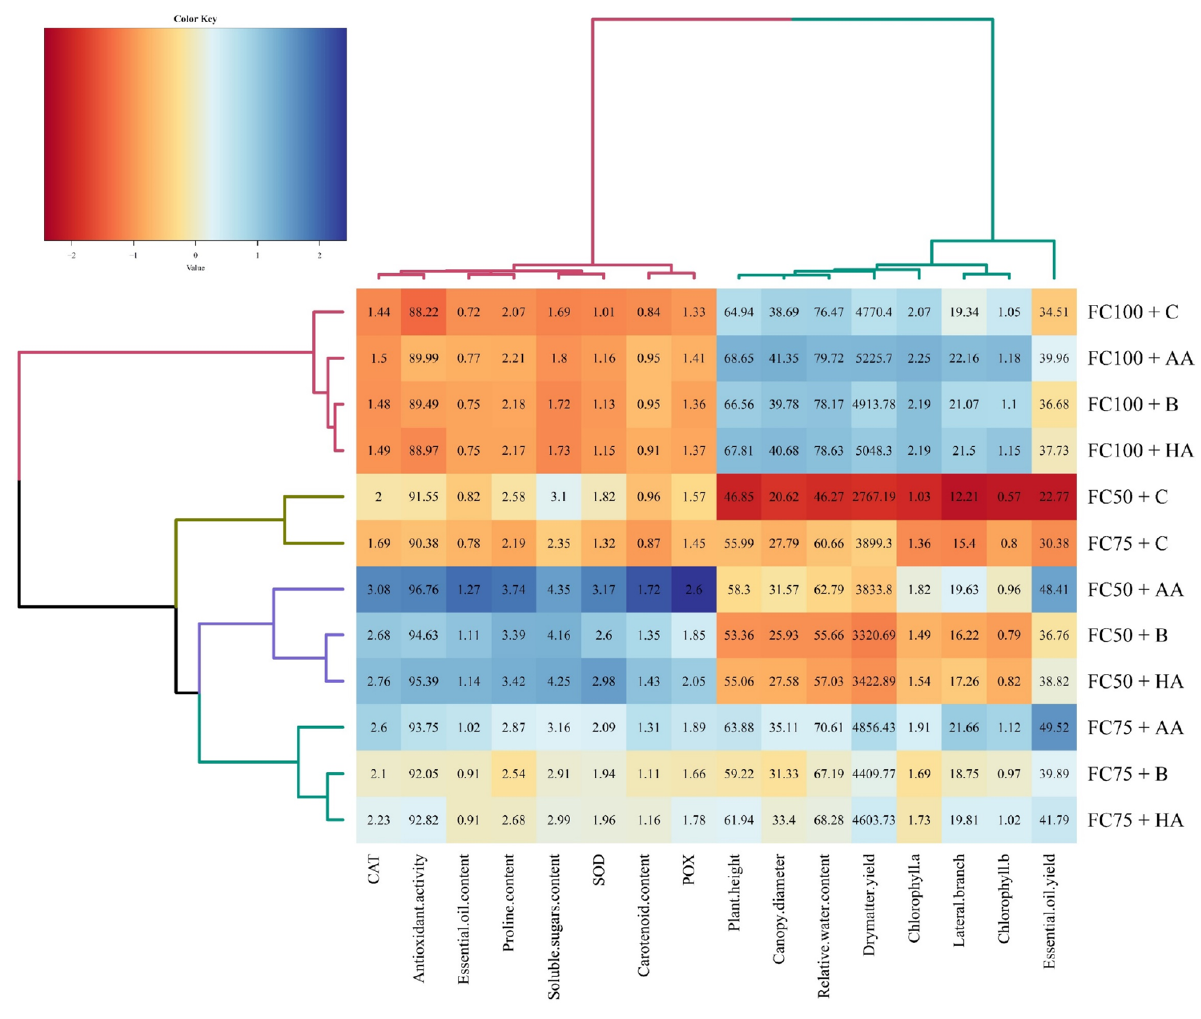
Figure 5. Heatmap clustering of irrigation regime (FC100, 100% field capacity; FC75, 75% field capacity; FC50, 50% field capacity) and fertilizer application ( C control, HA humic acid, B bacterial, AA amino acid) sources based on morpho-physiological characteristics in summer savory ( Satureja hortensis L.). The key color bar indicates standardized mean values (dark red indicates relatively low mean values; dark blue indicates relatively high mean